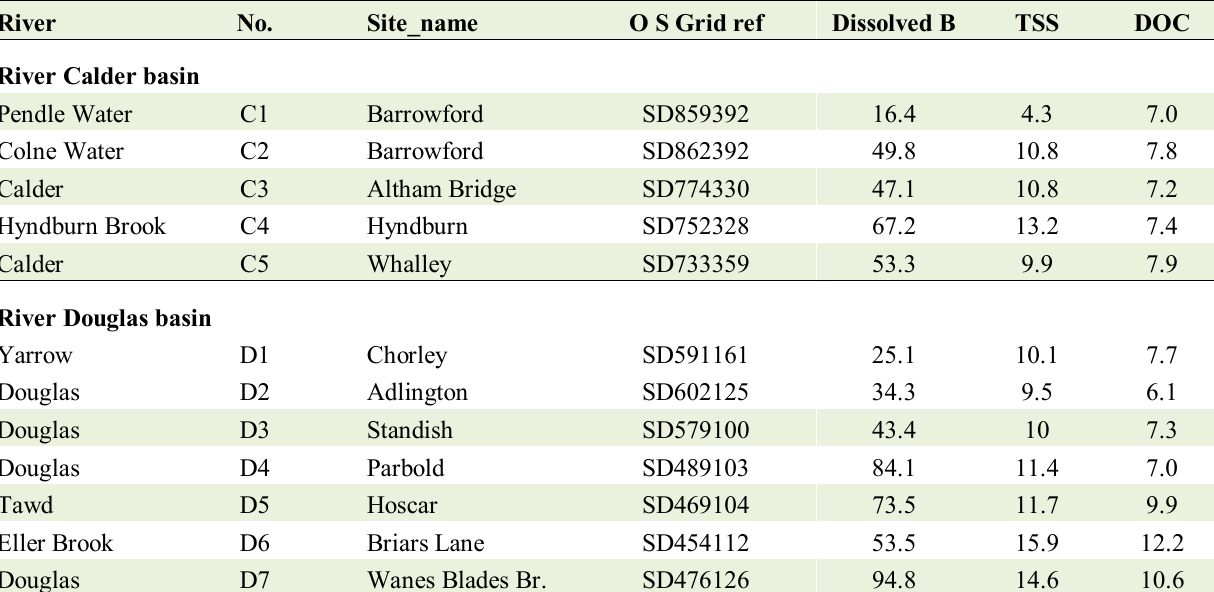
Table 1. Site names, locations, mean values (n = 42) for boron (B) (µg L −1 ), total suspended solids (TSS mg L −1 ) dissolved organic carbon (DOC mg L −1